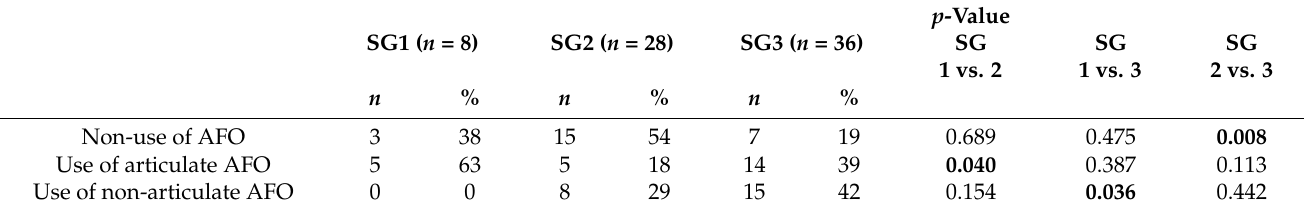
AFO: ankle foot orthosis; SG: subgroup; p -values marked with bold indicate statistically significant differences at the p < 0.05 level. Participants who used the articulated AFOs daily wore an AFO with resistance in the plantarflexion direction due to an oil damper and without stiffness in the dorsiflexion direction (Gait Solution Design; Kawamura Gishi, Osaka, Japan) or a posterior leaf spring plastic AFO with a Tamarack flexure joint (Becker Orthopedic, Troy, MI, USA). The par- ticipants who used non-articulated AFOs daily wore an ORTOP AFO (Pacific Supply Co., Ltd., Osaka, Japan) or posterior leaf spring plastic